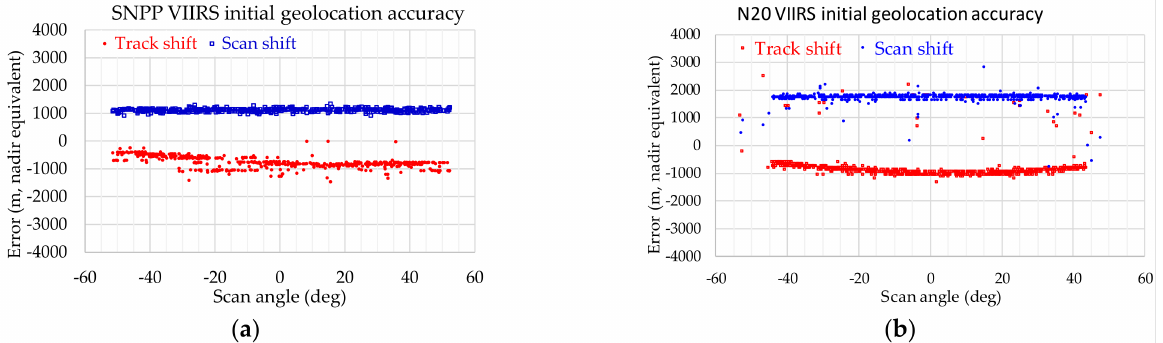
Figure 2. Initial geolocation accuracy for ( a ) SNPP and ( b ) N20 VIIRS